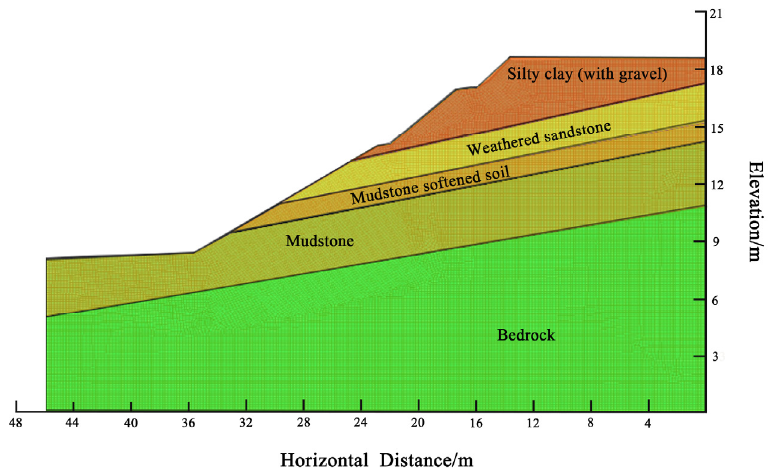
Figure 3. Finite element mesh schematic diagram of the main slide’s cross-section.